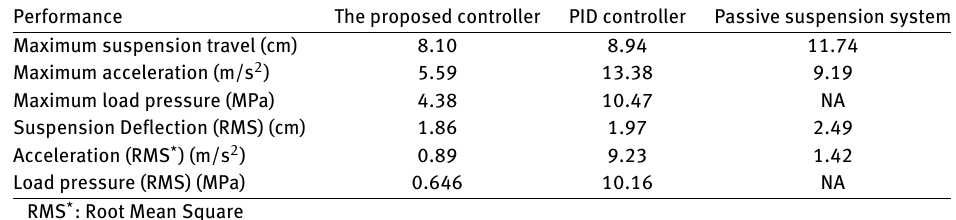
Table 8. Performance comparison while the system with varied parameters is imposed by bump road profile depicted in Figure 3